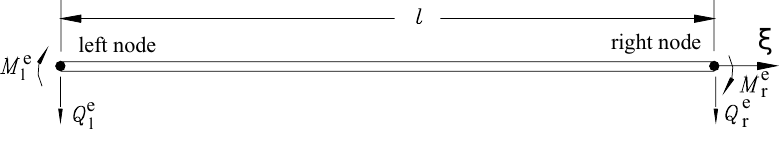
Fig. 3. Shear forces Q e l and Q e r , and bending moments M e l and M e r at the cross-section of the two nodes of a typical beam